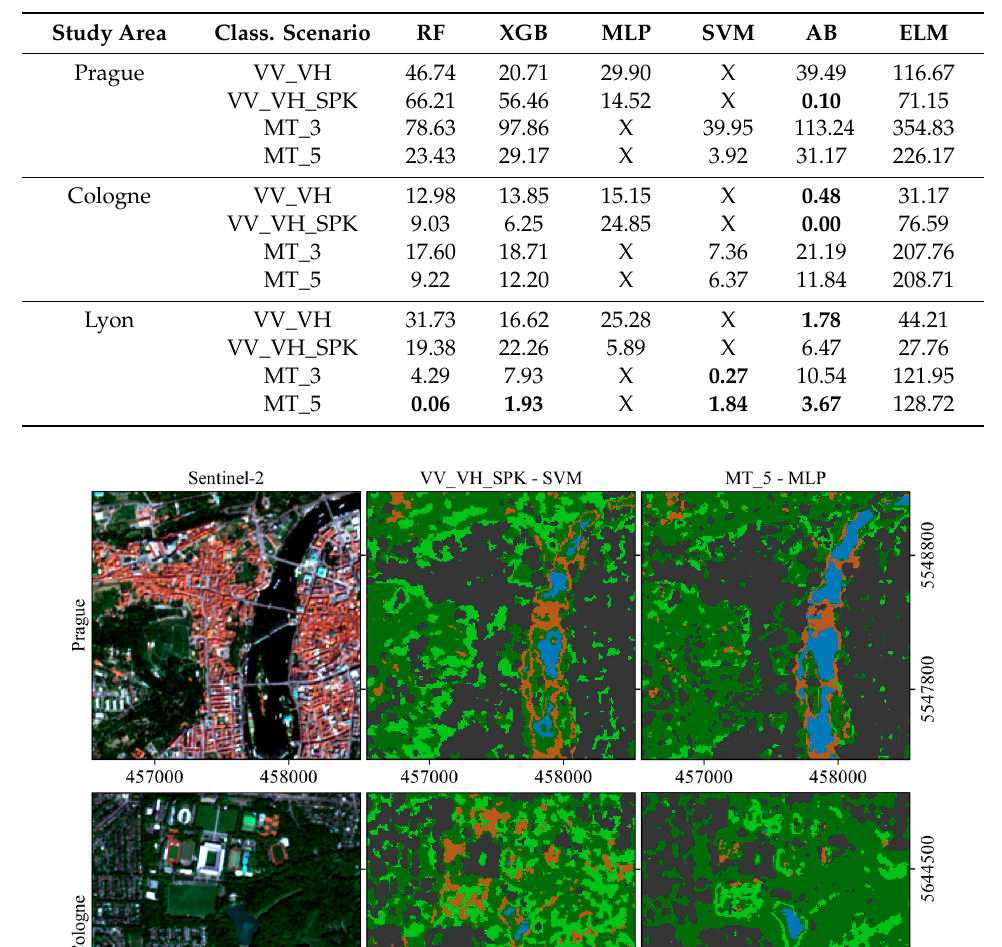
Table 5. McNemar’s chi-squared values test results comparing SVM and MLP classifiers with other classification algorithms in the single-date and MT classification scenarios, respectively. If a χ 2 value is less than 3.84 (bold values), the null hypothesis is not rejected, which indicates that the two classification results were not significantly di ff erent.